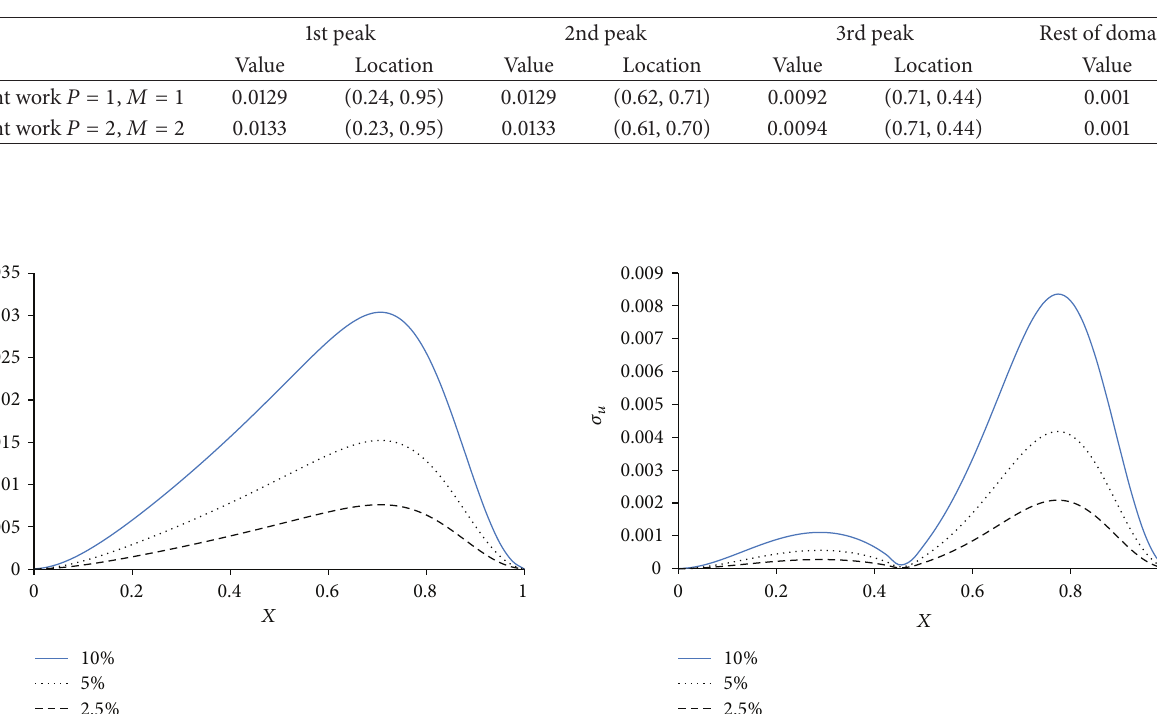
Table 3: Standard deviation of horizontal velocity component for different order ( 𝑃 ) and dimension ( 𝑀 ) (peaks from left to right).